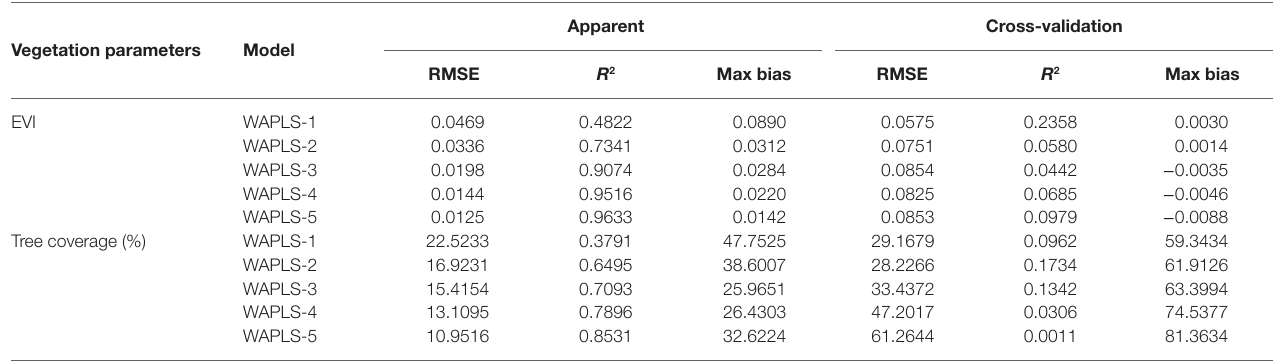
TABLE 4 | Performance of WAPLS model relating to EVI and canopy tree coverage and phytolith variance.